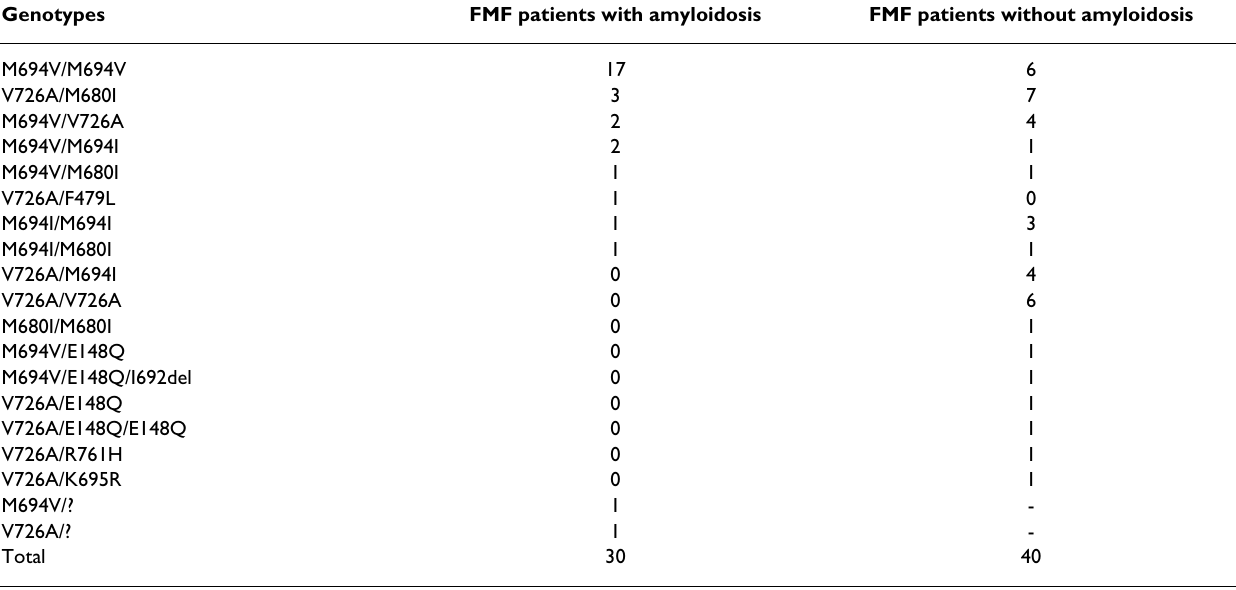
Table 1: Genotypes of the FMF patients with and without amyloidosis Genotypes